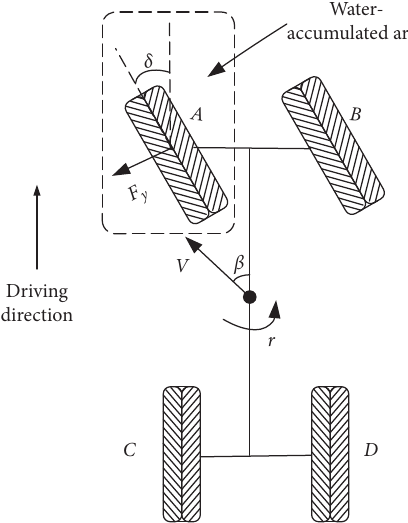
Figure 2: Schematic diagram of vehicle sliding caused by the water accumulated in the